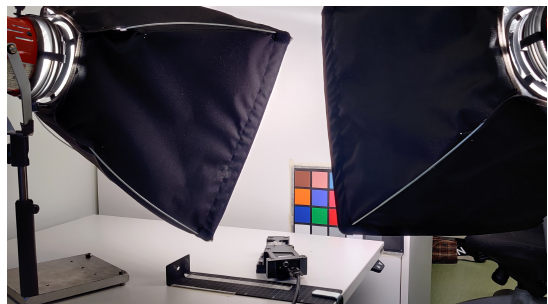
Figure 6. The used scanning setup: Two halogen lamps with a diffusor, color checker as an imaging target, and the hyperspectral imager, which was slid along the metallic ruler fixed to the desk.